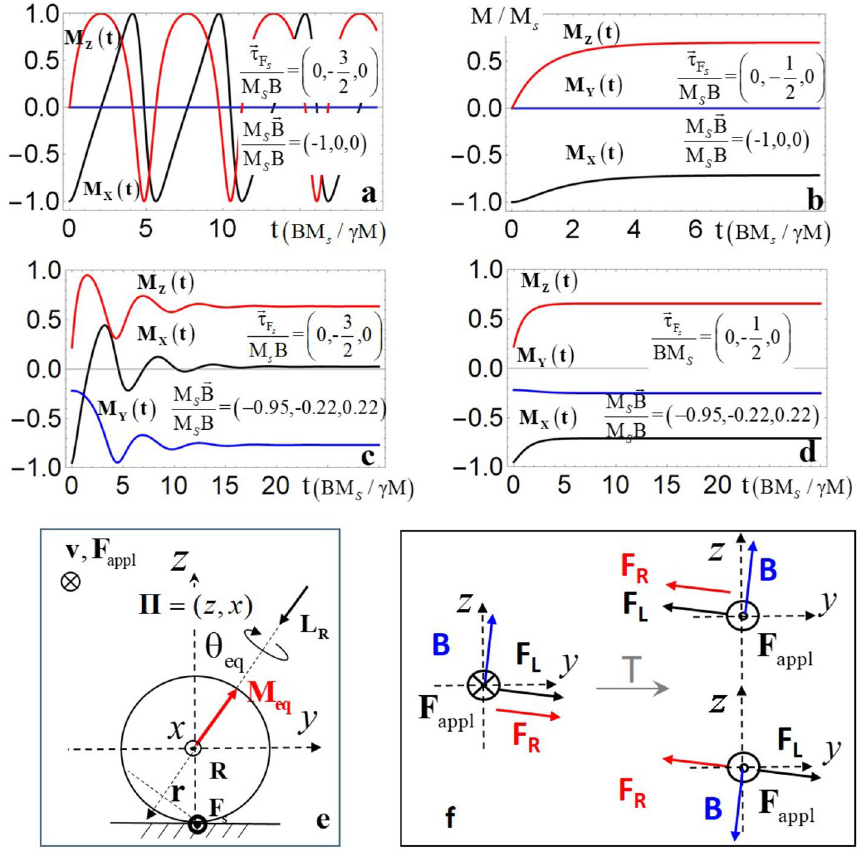
Figure 2. Dynamics of a revolving-up magnet. Initially, the magnetization (cid:31) M is parallel to a magnetic field (cid:31) B . Next, a mechanical torque (cid:31) τ (cid:31) M ( t ) evolves for ( a ) ( � v , � B ) ∈ � = ˆ z , ˆ x and |� τ F s | > |� τ max B | ; ( b ) F s is applied and (cid:31) (cid:30) | ; ( c ) ( � v , � B ) / ∈ � and |� τ F s | > |� τ max | ; ( d ) ( � v , � B ) / ∈ � and |� τ F s | < |� τ max | ; ( e ) Schematical ( � v , � B ) ∈ � and |� τ F s | ≤ |� τ max B B B representation of geometrical axes, forces and angular momentum acting on a rolling magnetic sphere with inclined axis. All definitions correspond to the text; ( f ) Comparison of the Lorentz force for a positive charge and the force due to the SR under the local ( (cid:31) F appl reverses, (cid:31) B remains unchanged) and global ( (cid:31) F appl reverses, (cid:31) B reverses) time